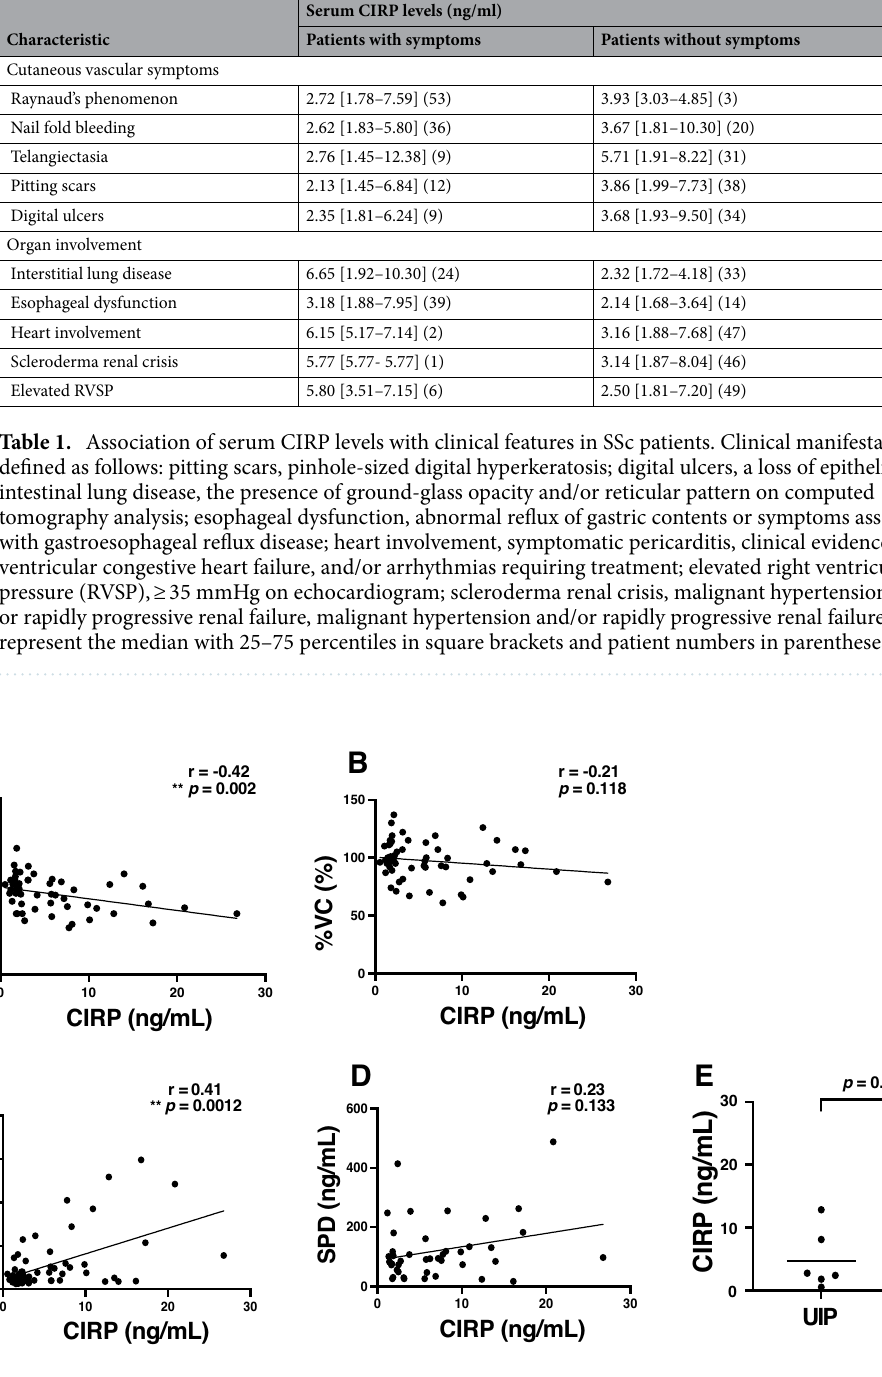
Figure 2. Correlation between serum CIRP levels and ILD parameters. ( A , B ) Negative correlation between serum cold-inducible RNA-binding protein (CIRP) levels and percent predicted diffusing capacity for carbon monoxide (%DL CO , A) or the percent predicted vital capacity (%VC, B) in systemic sclerosis (SSc) patients. ( C , D ) Positive correlation between serum CIRP levels and serum Krebs von den Lungen-6 (KL-6, C ) or surfactant protein D (SP-D , D ) in SSc patients. ( E ) Serum CIRP levels in SSc patients with usual interstitial pneumonia (UIP) and nonspecific interstitial pneumonia (NSIP). The solid lines represent the regression lines ( A – D ). ** p <